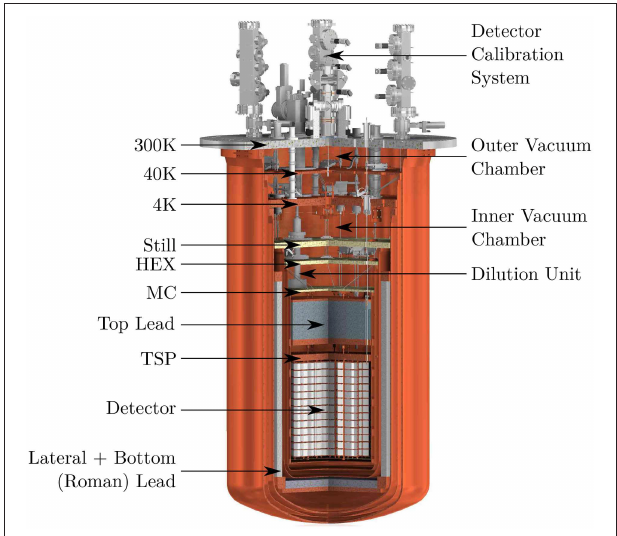
FIGURE 4 | The CUORE cryostat. The different thermal stages, the lead shields, the vacuum chambers and the cooling units are indicated. See original in the official CUORE experiment website. Available online at: https://cuore.